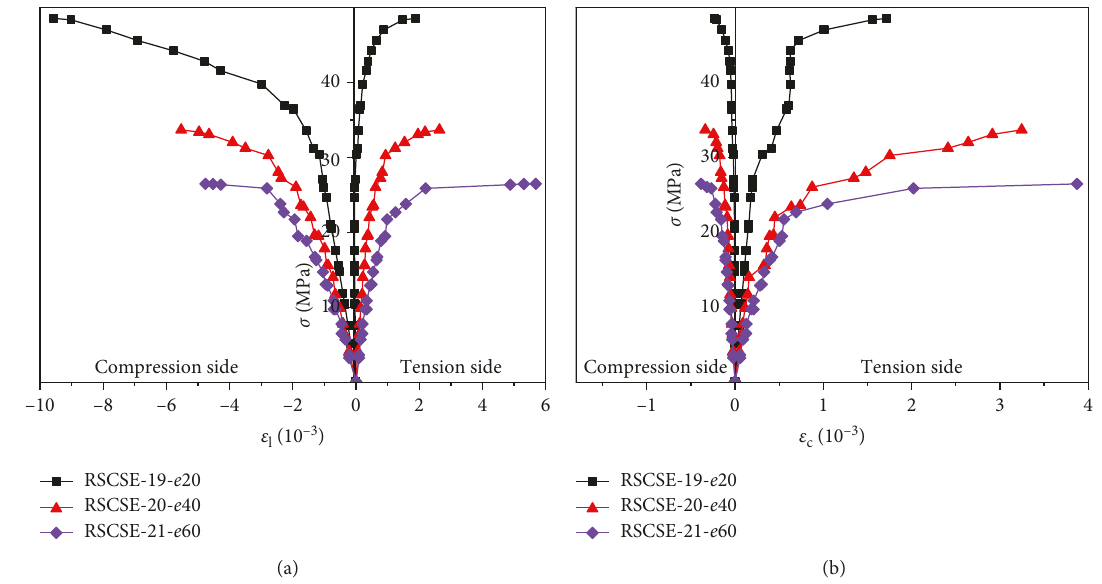
Figure 7: Effect of eccentricity on the stress-strain curve (C60- c 100-L500): (a) longitudinal strain; (b) circumferential strain.